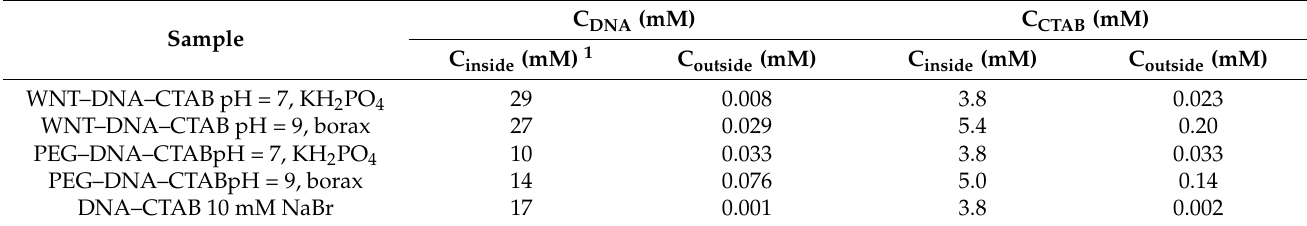
Table 1. DNA and surfactant concentrations inside and outside of the gel